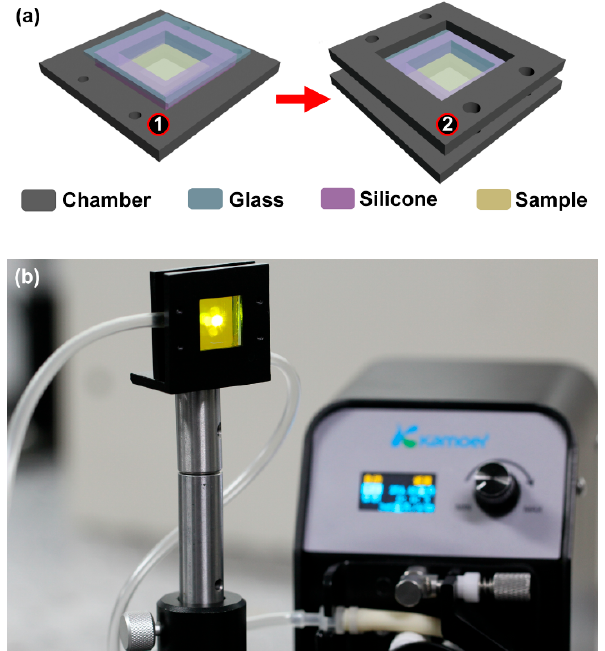
Figure 2. ( a ) Schematic of the sealed sample chamber. The gray, blue, pink, and yellow rectangles represent the sample chamber, glass coating, silicone, and the laser sample, respectively. ( b ) Photograph of the measurement system.